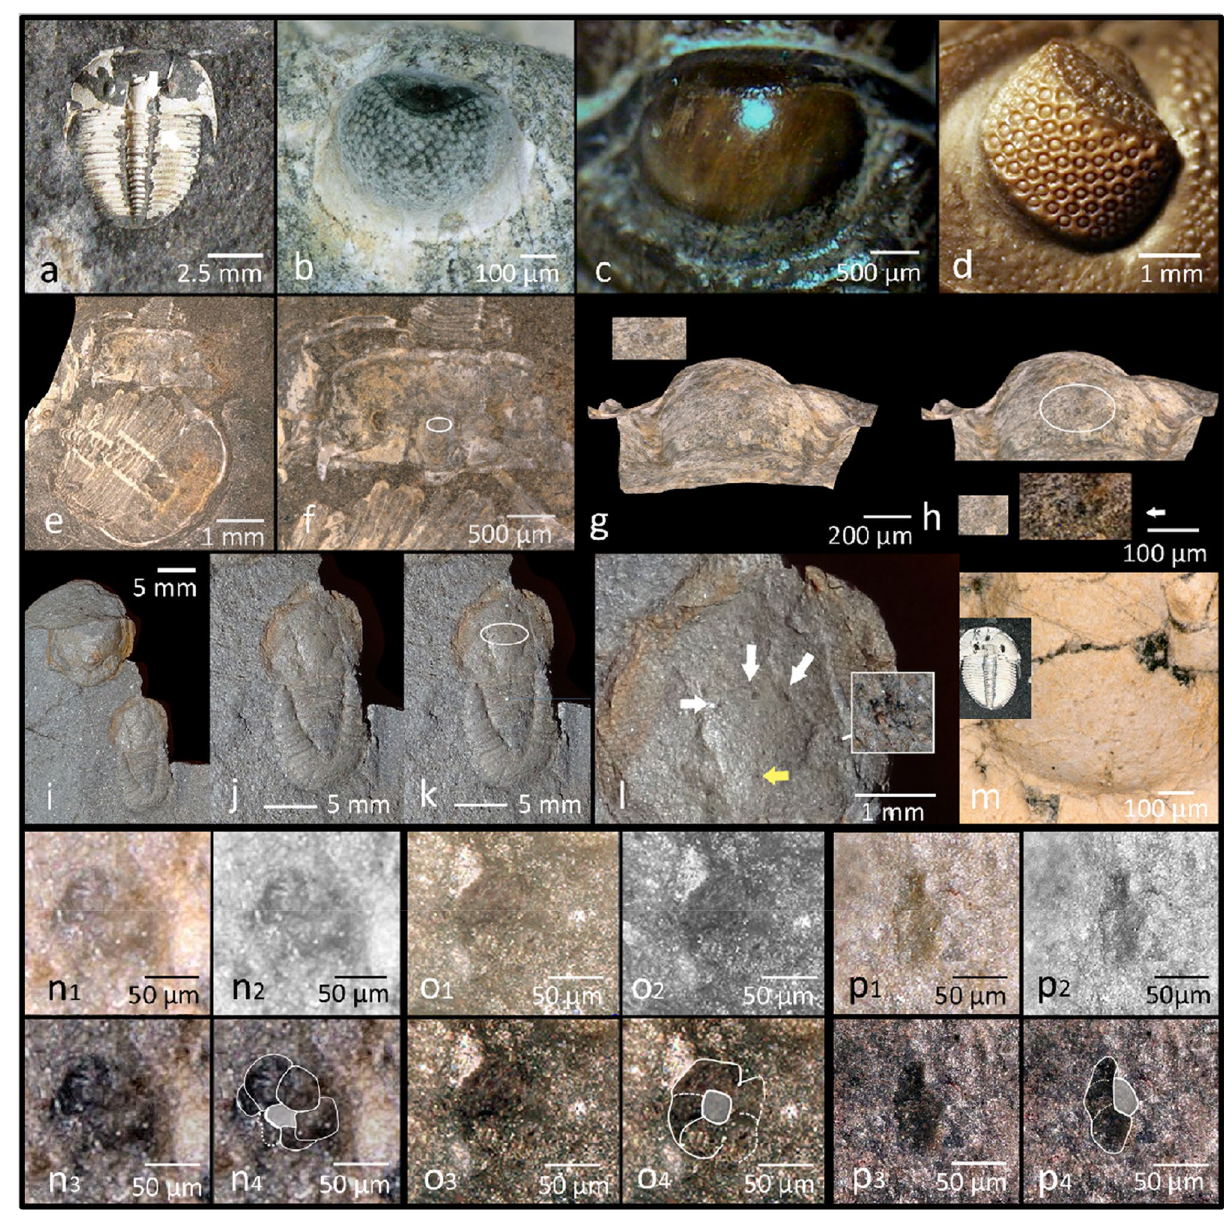
Gerastos cuvieri (Steininger, 1831), Middle Devonian, Germany. ( d ) Schizochroal eye of Eldredgeops (Phacops) rana crassituberculata Stumm, 1953, Middle Devonian, USA. ( e ) A. koninckii, two larval stages. f ) Upper specimen with location of the median eyes indicated. ( g ) Median eyes. ( h , g ) enlarged). ( i ) Cyclopyge sibilla Šnajdr, 1982, Ordovician, Morocco; 2 specimens, the lower larval. ( j ) Relevant specimen of ( i ). ( k , j ) Position of the median eyes indicated. ( l ) Median eyes in ( j , k ) indicated by white arrows. Yellow arrow: dorsal organ, comp. ( h , i ). Insert: dark structure in the fossil, which is not a median eye. m ) Fully shelled glabella of A. koninckii (insert), no median eyes visible. ( n 1–4 ) Left median eye of C. sibilla ( l ), different contrasts. ( o 1–4 ) Median median eye of C. sibilla ( l ), different contrasts. ( p 1–4 ) right median eye of C. sibilla ( l ), different